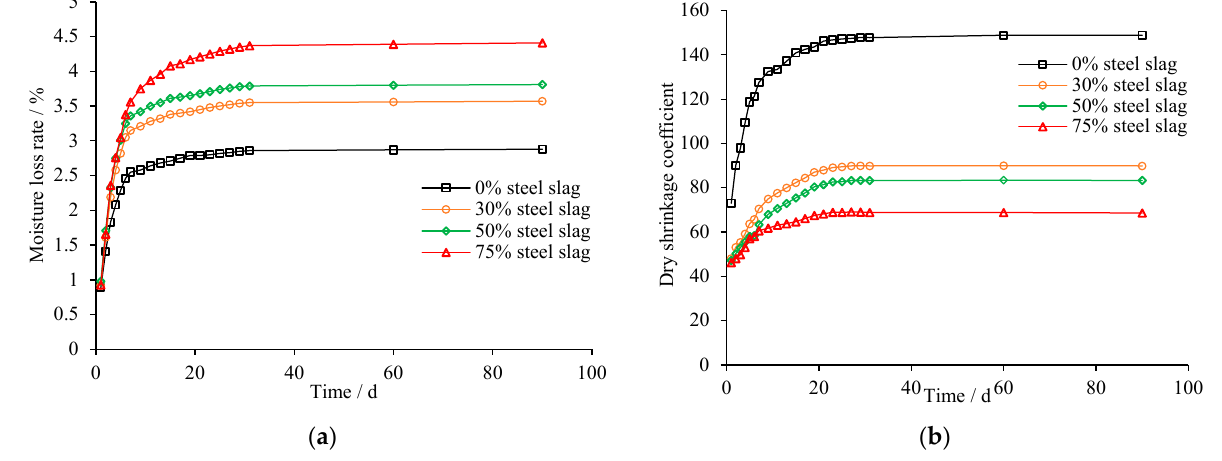
Figure 12. Shrinkage of mixtures with different steel slag content (4% cement content). ( a ) Moisture loss; ( b ) Shrinkage coefficient.